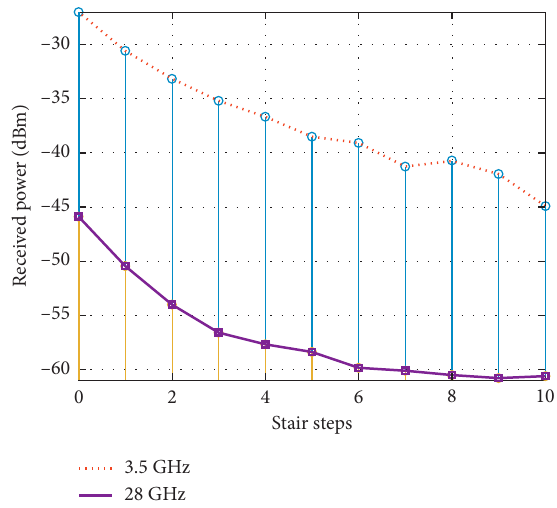
Figure 4: Received power among stair steps at 3.5GHz and